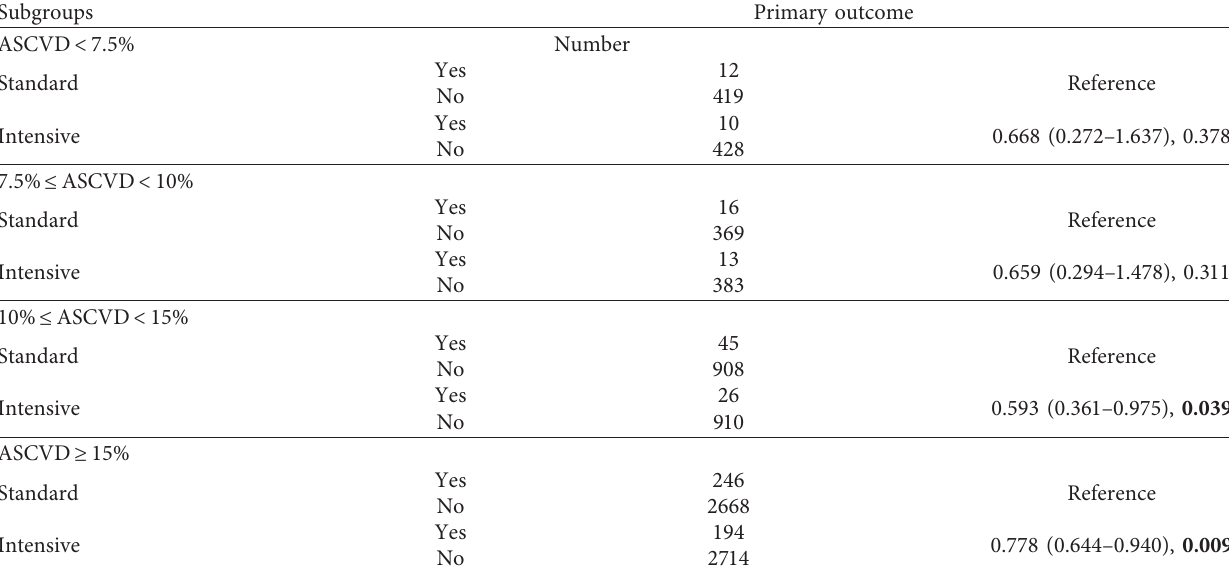
Table 2: Primary outcome in the intensive- and standard-treatment